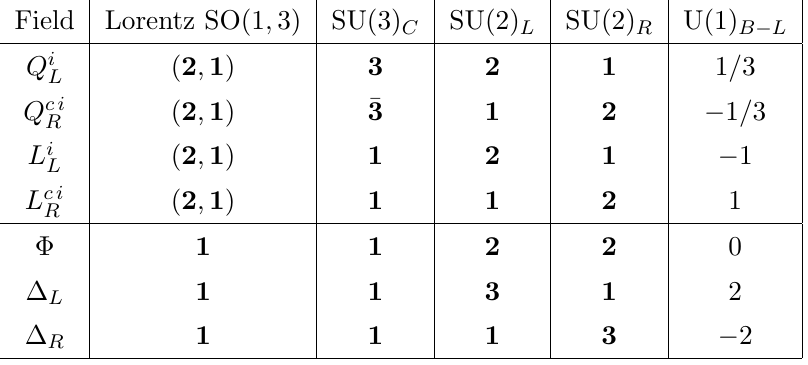
Table 1 . Matter content and charge assignments with i being generation